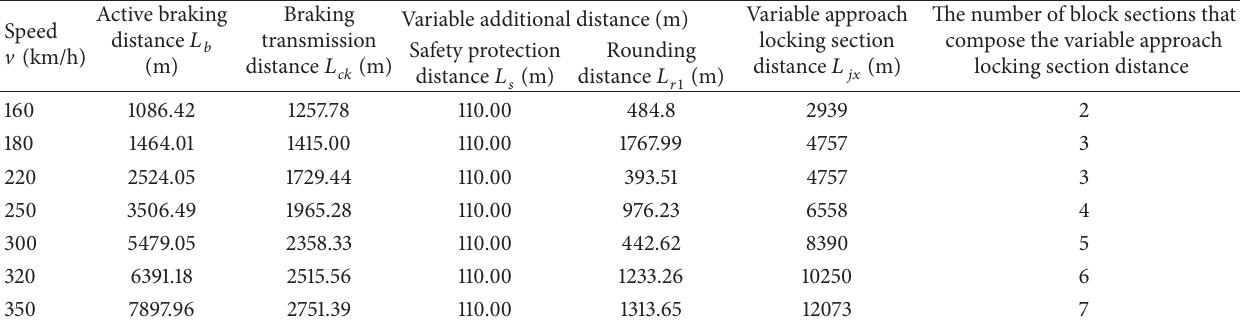
Table 3: The downward variable approach locking section of Shaoguan station.